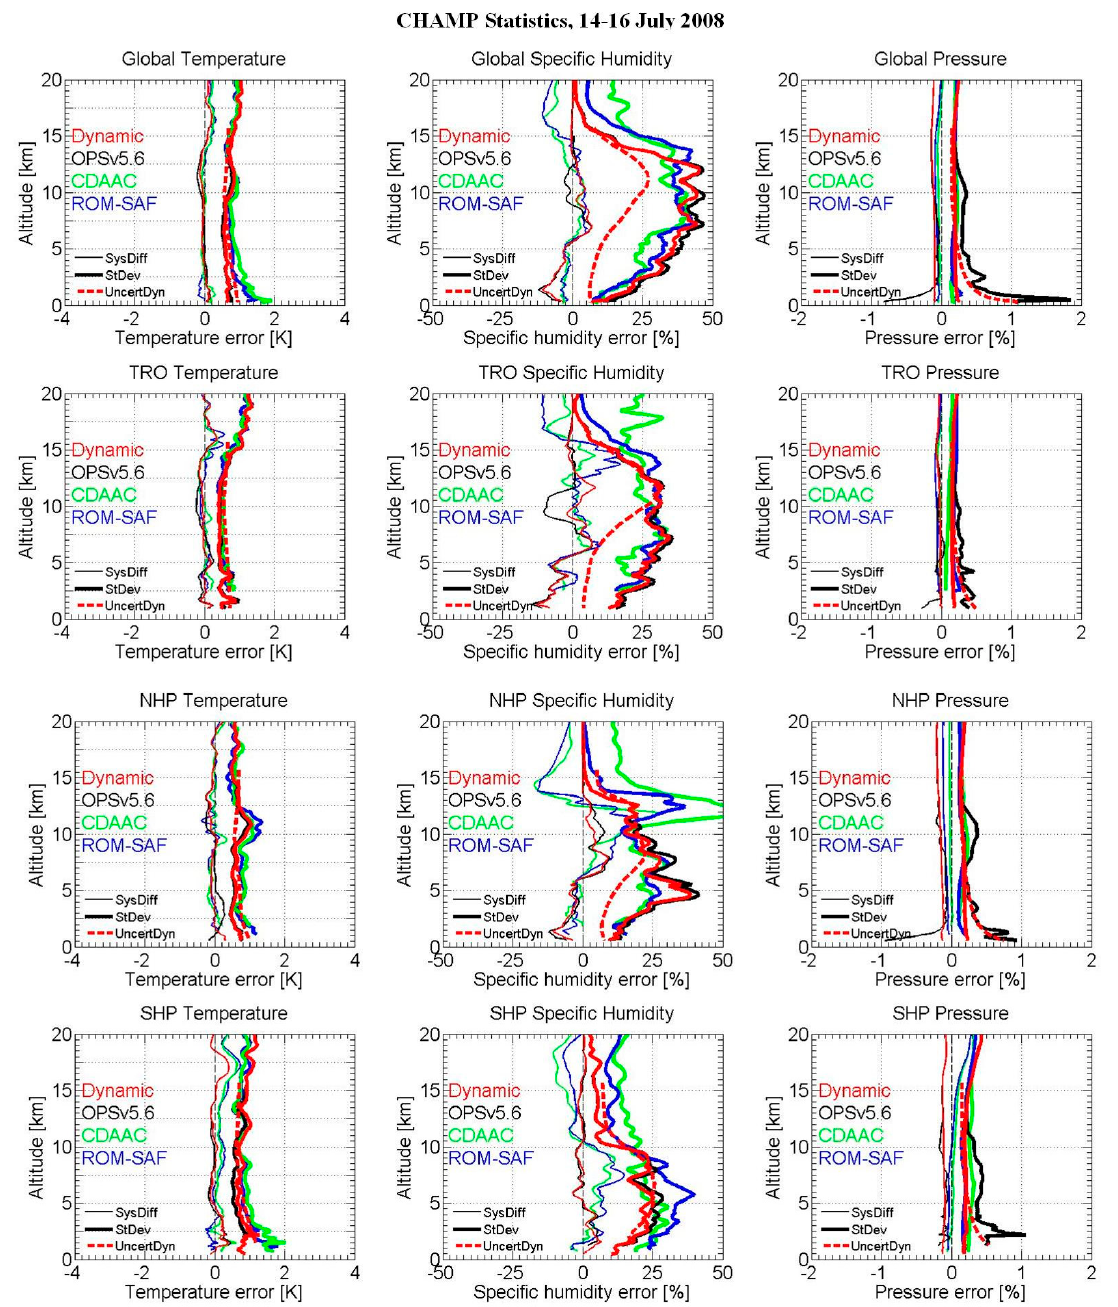
Figure 8. Systematic differences (SysDiff) and standard deviations (StDev) of retrieved temperature (left column), specific humidity (middle column), and pressure (right column), relative to ECMWF co-located analysis profiles as reference, of the ensemble of CHAMP events on 14-16 July 2008. Statistics for the dynamic (red), OPSv5.6 (black), CDAAC (green), and ROM-SAF (blue) approach are shown for four representative regions (top to bottom: Global, TRO, NHP, SHP). The propagated uncertainties of retrieved profiles from the dynamic approach (UncertDyn; red-dashed) are shown as well.